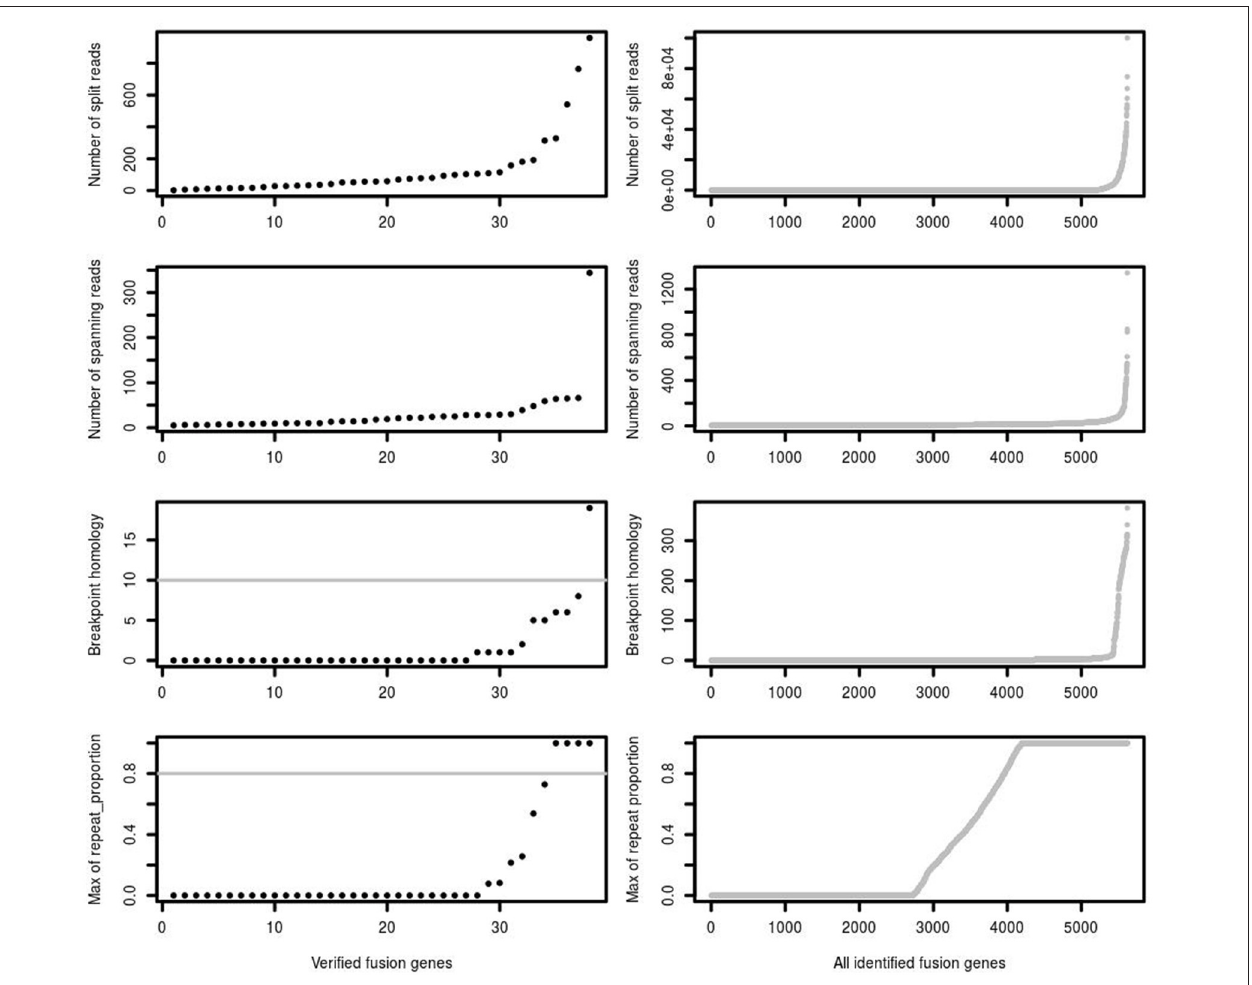
FIGURE 3 | The number of split reads, spanning reads and breakpoint homology between verified and identified fusions. deFuse reported most of the verified fusion genes in 16 glioblastoma samples as containing < 200 split reads, < 50 spanning reads and < 10 bp breakpoint homology. The maximum proportion of spanning reads in fusion partners aligned on a repeat region (repeat_proportion) is < 80% among most of the verified